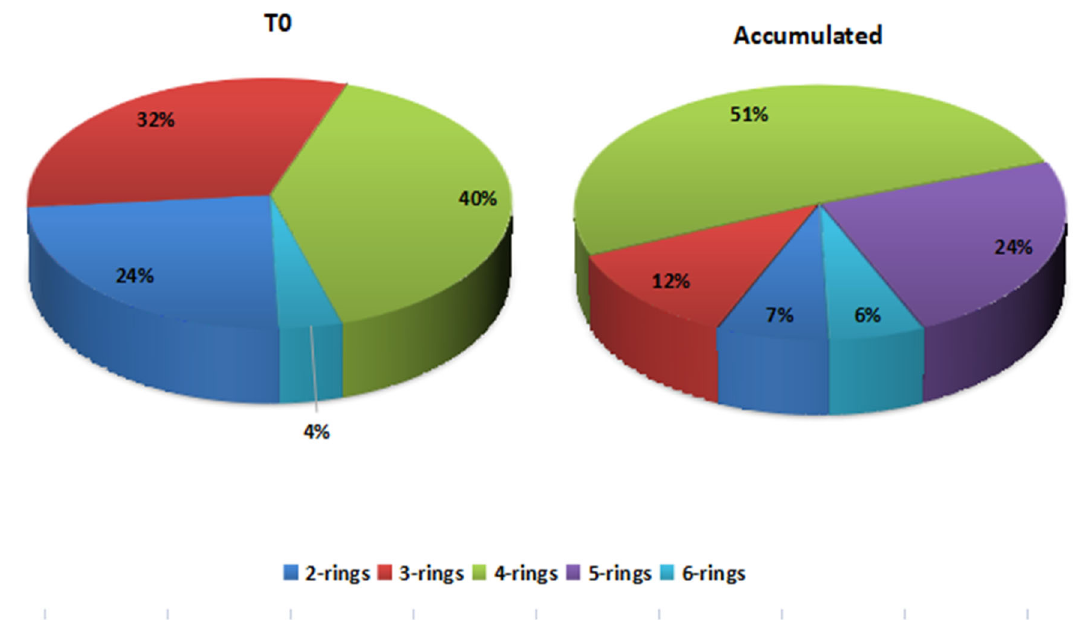
Figure 4. Grouped by ring number, as a percentage of total PAHs, in pre-exposure moss (T0) and accumulated in exposed moss pockets (created by author).